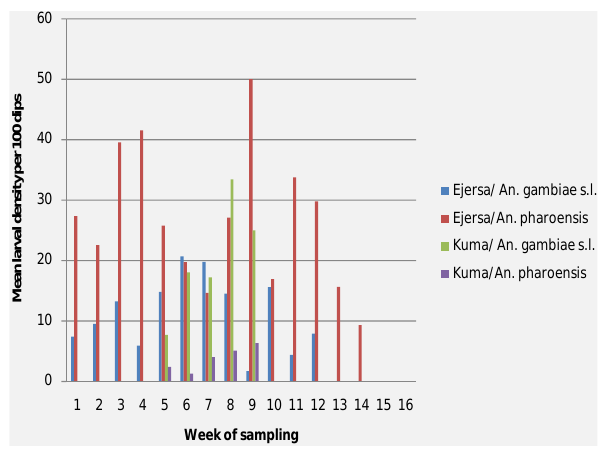
Figure 3. Mean number of larvae (Number of larvae/100dips) of An. gambiae s.l. and An. Fig. 3. Mean number of larvae (Number of larvae/100 dips) of pharoensis for the villages of Ejersa and Kuma (n=16 surveys). An. gambiae s.l. and An. pharoensis for the villages of Ejersa and Kuma ( n = 16 surveys).